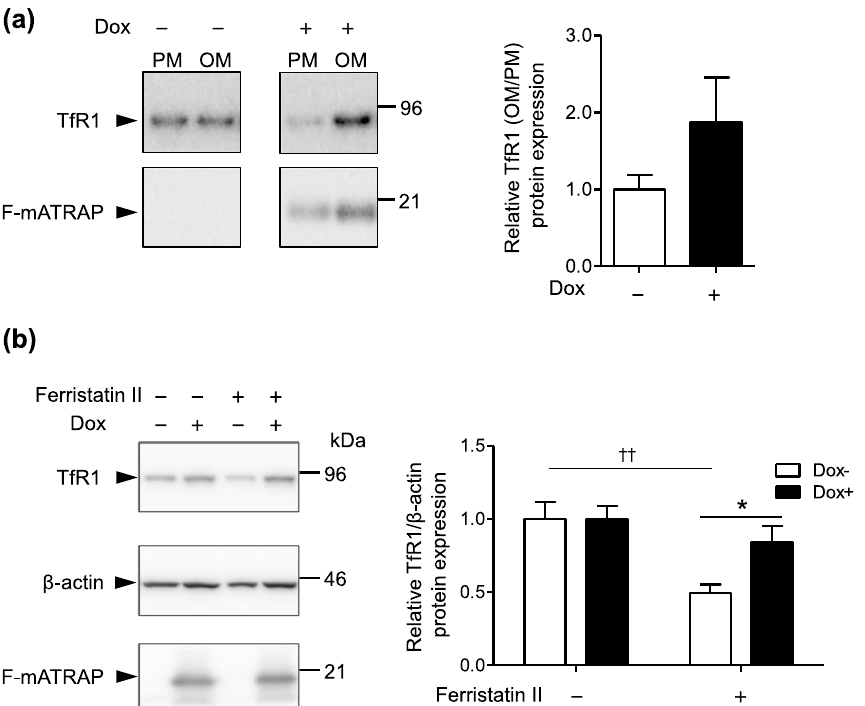
Figure 7. Effects of ATRAP expression on the membrane fractions expression of TfR1 and ferristatin II-induced TfR1 degradation. ( a ) Cell fractionation analysis of the expression of TfR1 in membrane fractions. Plasma membrane (PM) and organelle membrane (OM) fractions were analyzed by western blotting using the indicated anitbodies. Quantitative results are shown in the right panel. n = 2. ( b ) Western blot analysis of TfR1 protein expression following ferristatin II treatment (0 or 10 μM) for 4 h. The HEK293_F-mATRAP cells were cultured with or without Dox (Dox+/−). (n = 5) Total cell lysates were analyzed with the indicated antibodies. Representative western blot results are shown in the top panel. Quantitative results are shown in the right panel. * p < 0.05 vs. ferristatin II; †† p < 0.01 vs. Dox+ cells, as determined by two-way ANOVA with Bonferroni’s post- hoc test. The data shown are presented as the mean ±